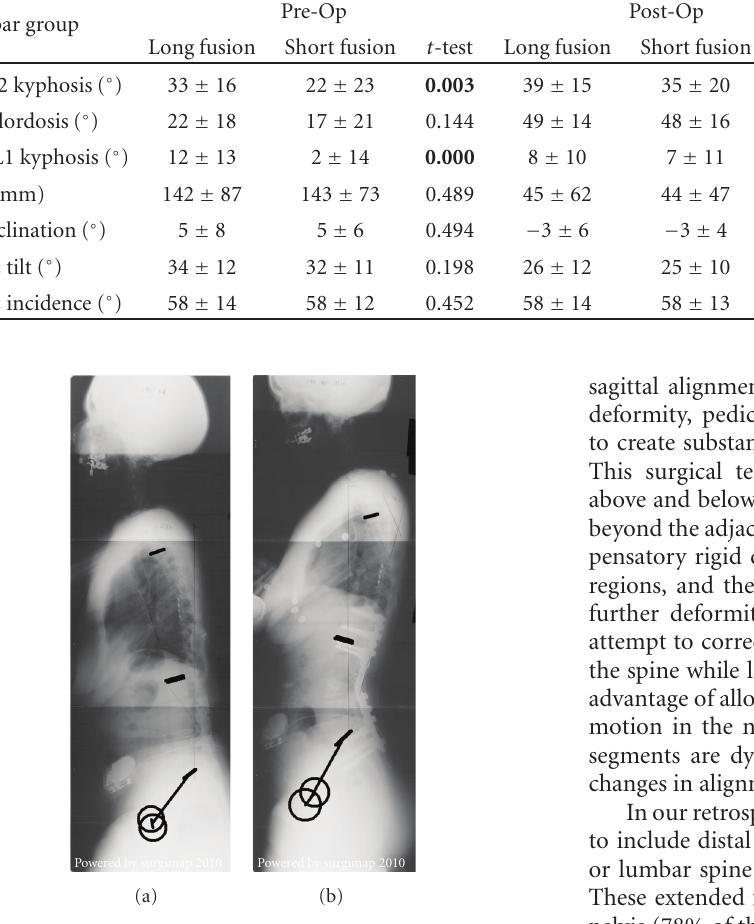
Figure 6: Lumbar resection, limited fusion.